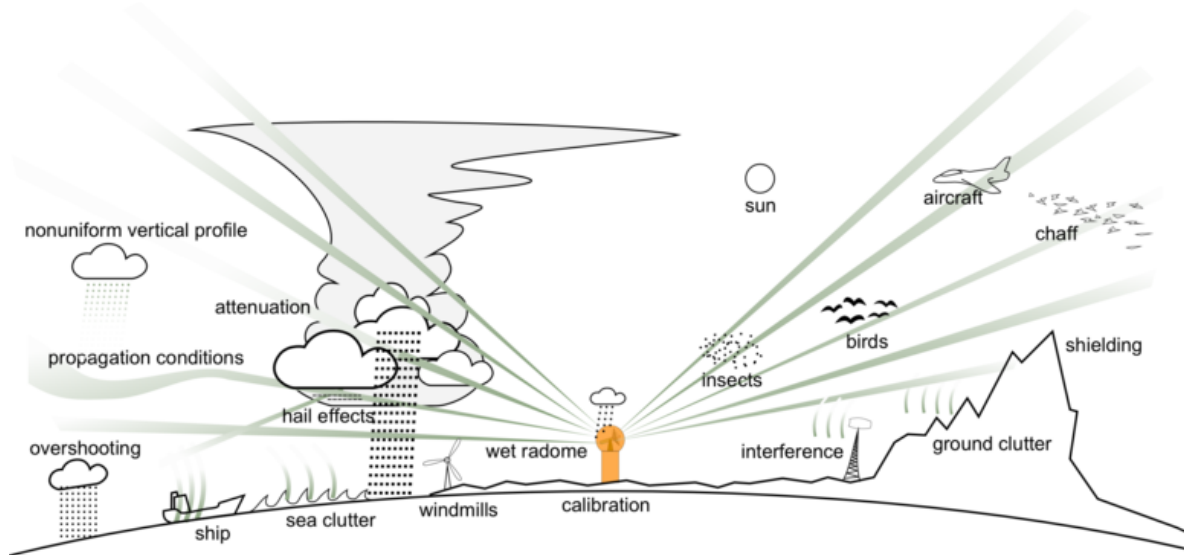
Figure 1. Example of error sources effecting weather radar measurements. Figure provided by Markus Peura, Finnish Meteorological Institute (FMI), and used with